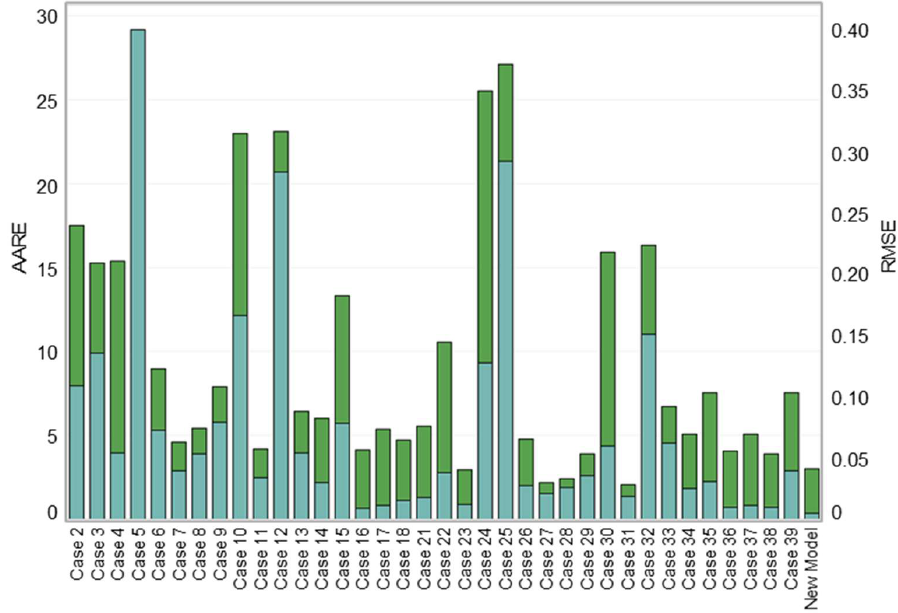
Figure 12. Model evaluation for liquid holdup predictions in terms of average absolute relative error and RMSE.